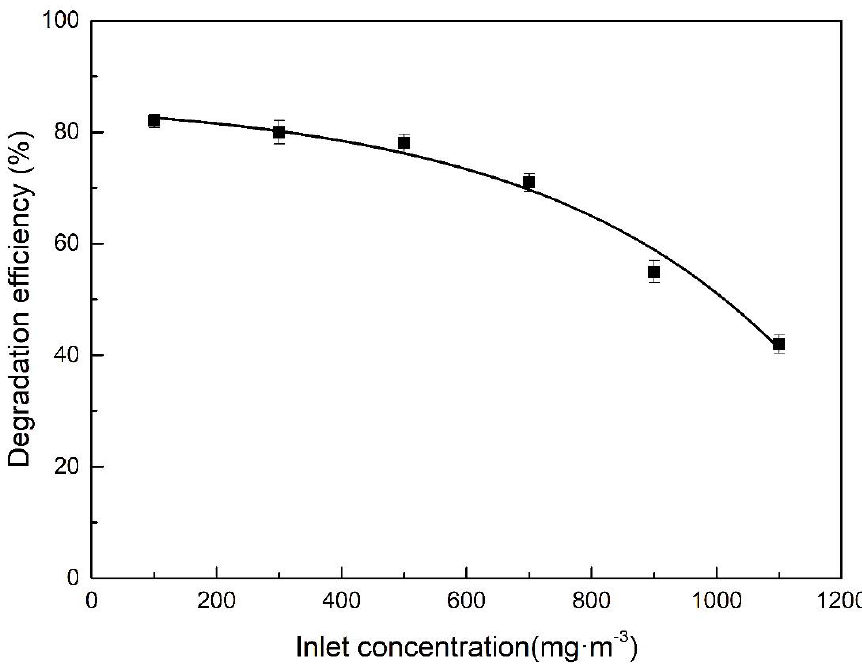
Figure 7. Influence of import concentration on chlorobenzene degradation (HRT = 5.5 s, oxygen concentration = 10%, discharge voltage = 7 kV, chlorobenzene inlet concentration = 100–1100 mg·m −3 ).